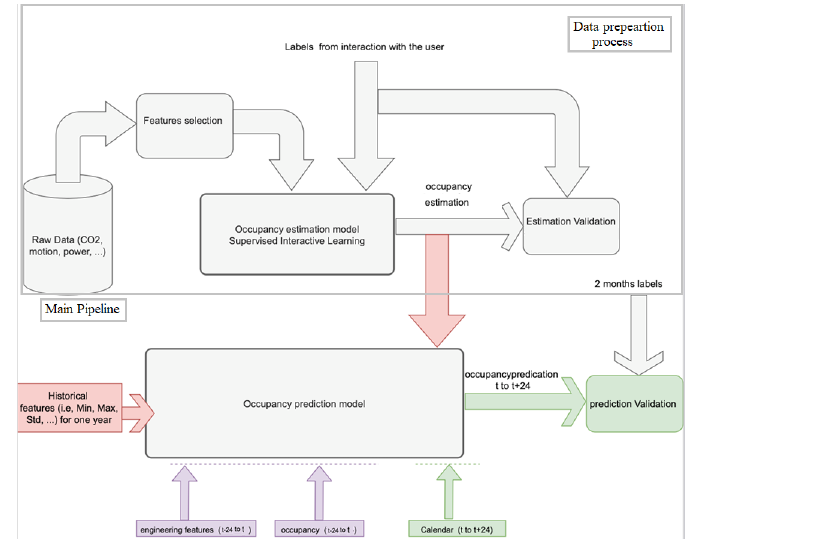
Figure 1. General occupancy prediction methodology. The following are the two primary processes: (1) the data preparation process through the generation of specific occupancy labels for existing unlabeled data, and (2) the main pipeline, which leverages the data created by the first step, as well as other extracted features, to estimate occupancy for various window